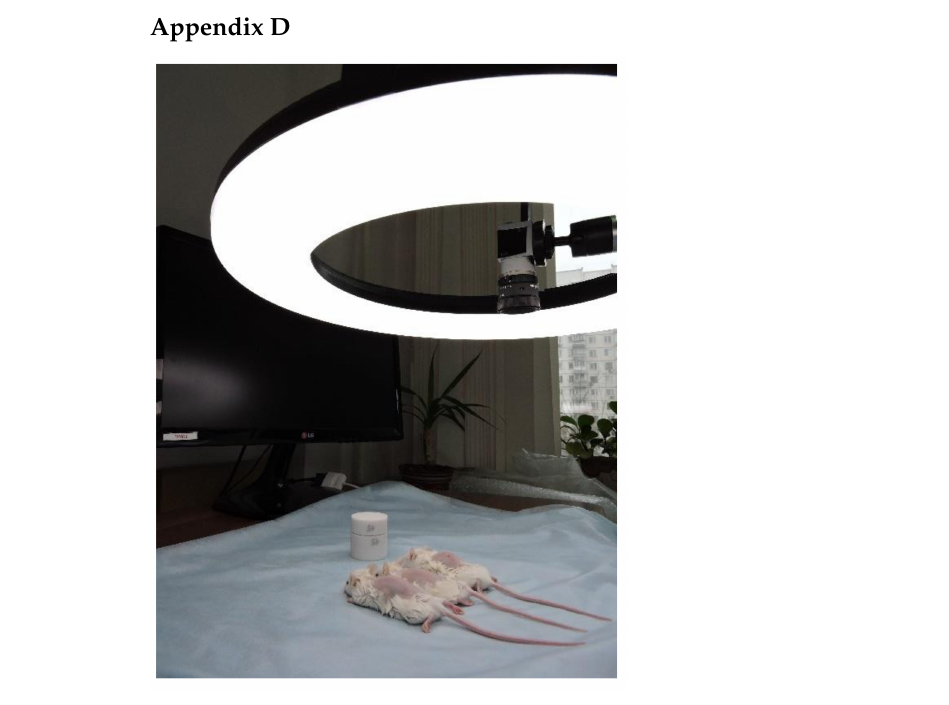
Figure A4. Position of the RGB camera and the light source during colorimetric assay of erythema.